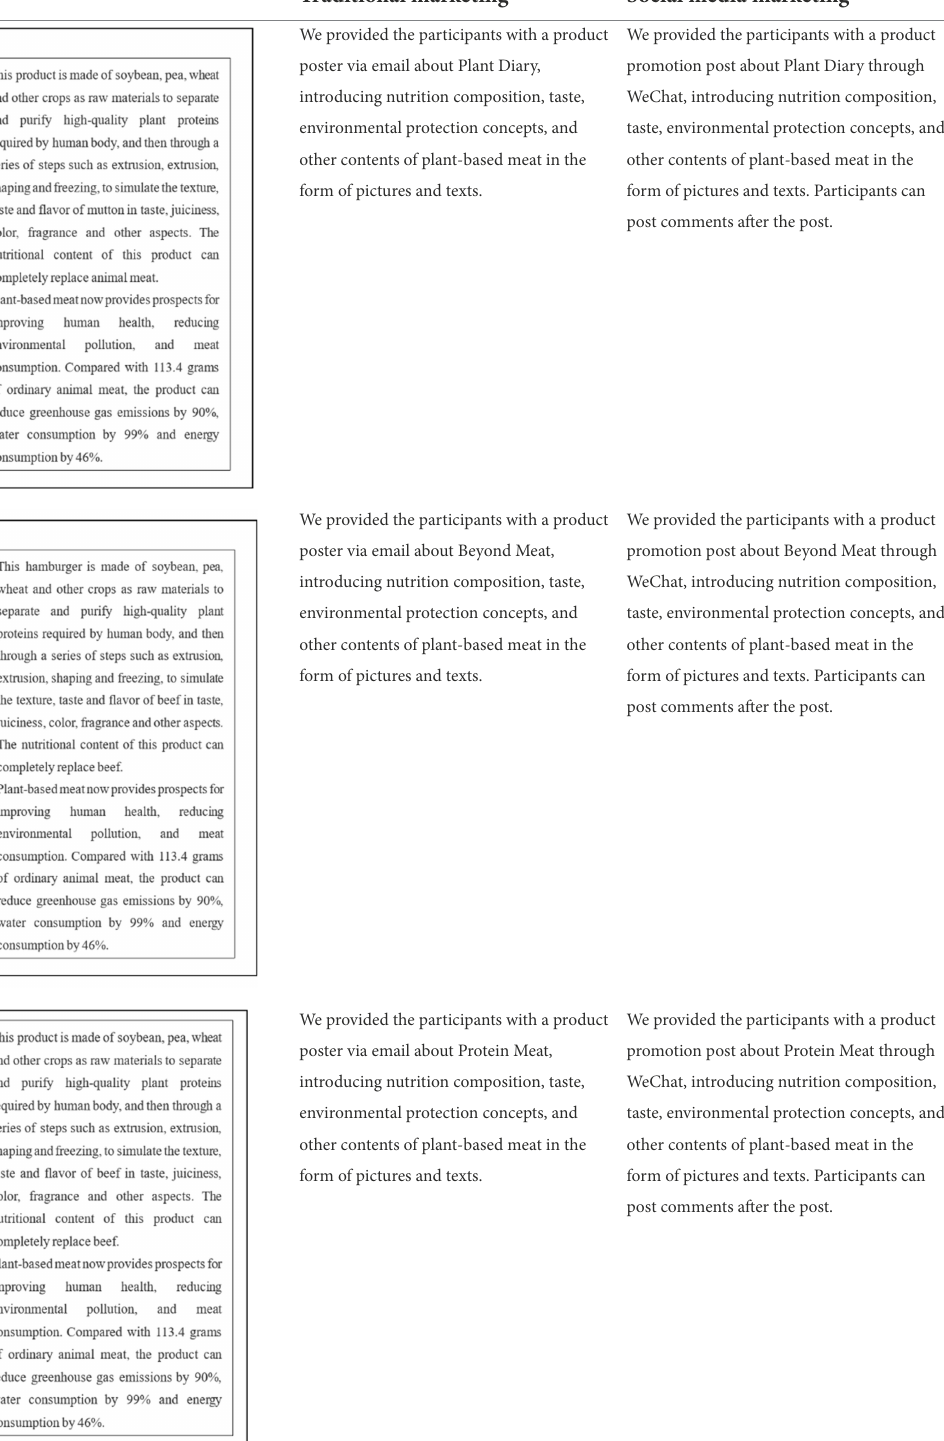
TABLE 1 Manipulation materials (Study